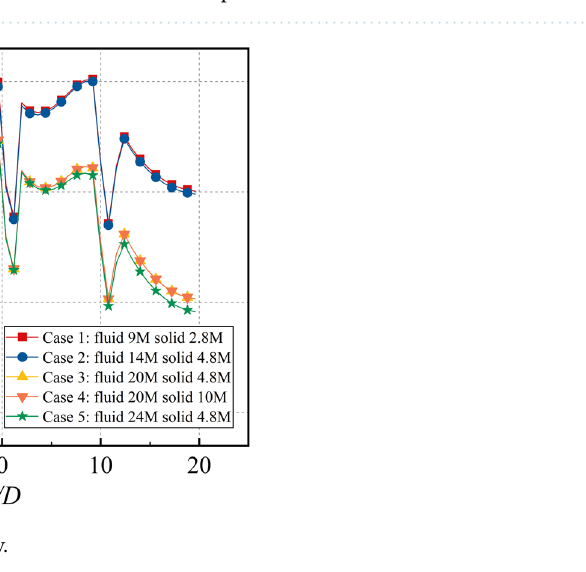
Figure 11. Numerical validation of internal cooling with the experimental results 36,37 . ( a ) Local heat transfer with ribs 36 ; ( b ) Multiple-jet impingement heat transfer with pin fins and effusion holes 37 .